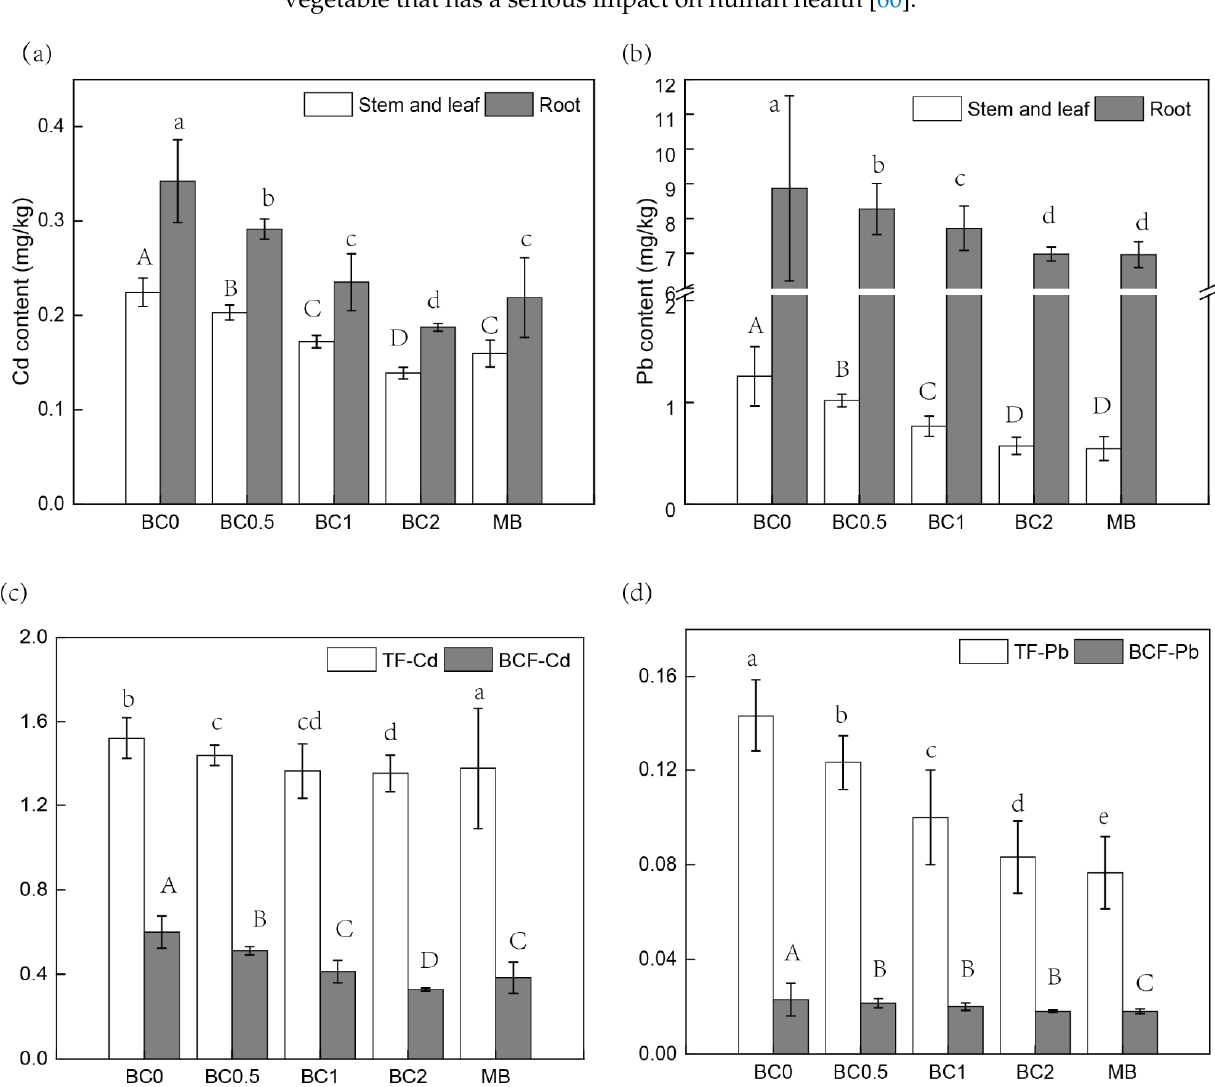
Figure 6. The Cd ( a , c ) and Pb ( b , d ) accumulation in the edible part of pak choi based on fresh weight. BC0, BC0.5, BC1, and BC2 mean as soil applied with T-BC of four rate (0, 0.5, 1, and 2% (w/w)); MB means as soil applied with biochar (2% (w/w)) from mango leaves.